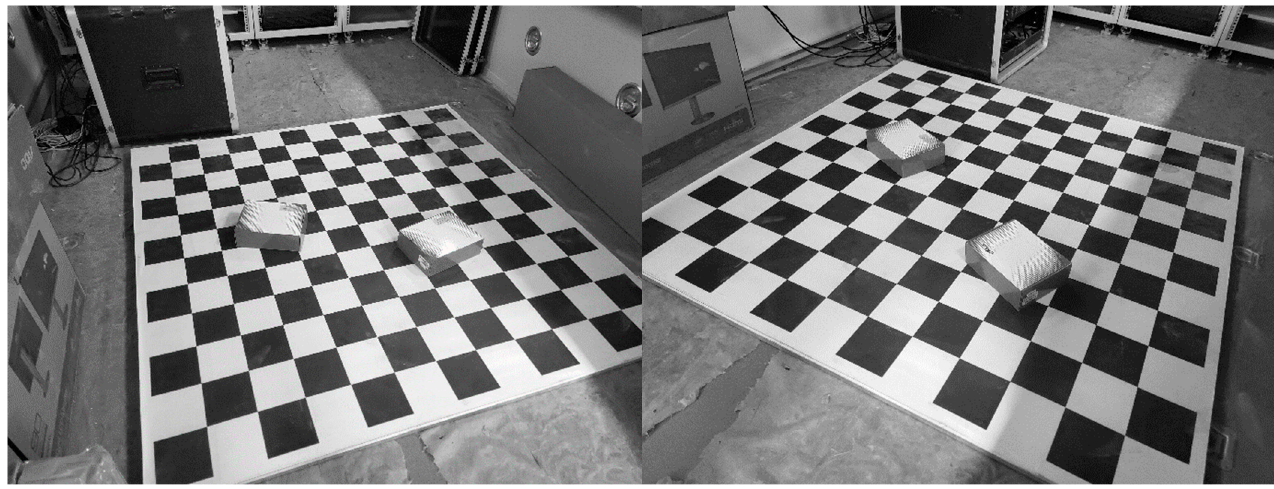
Figure 9. Real images from two different views.